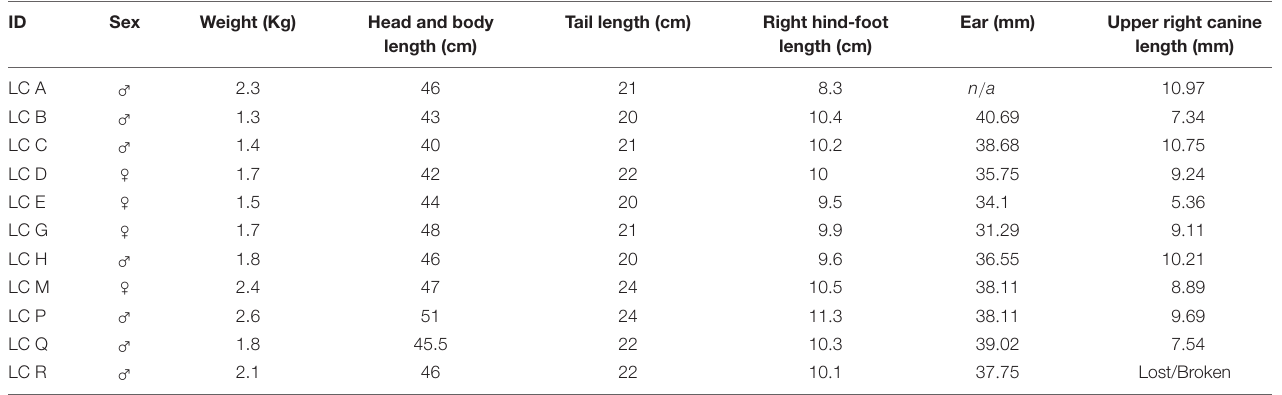
TABLE 1 | Physical characteristics of leopard cats captured at the study site, Lada Estate.